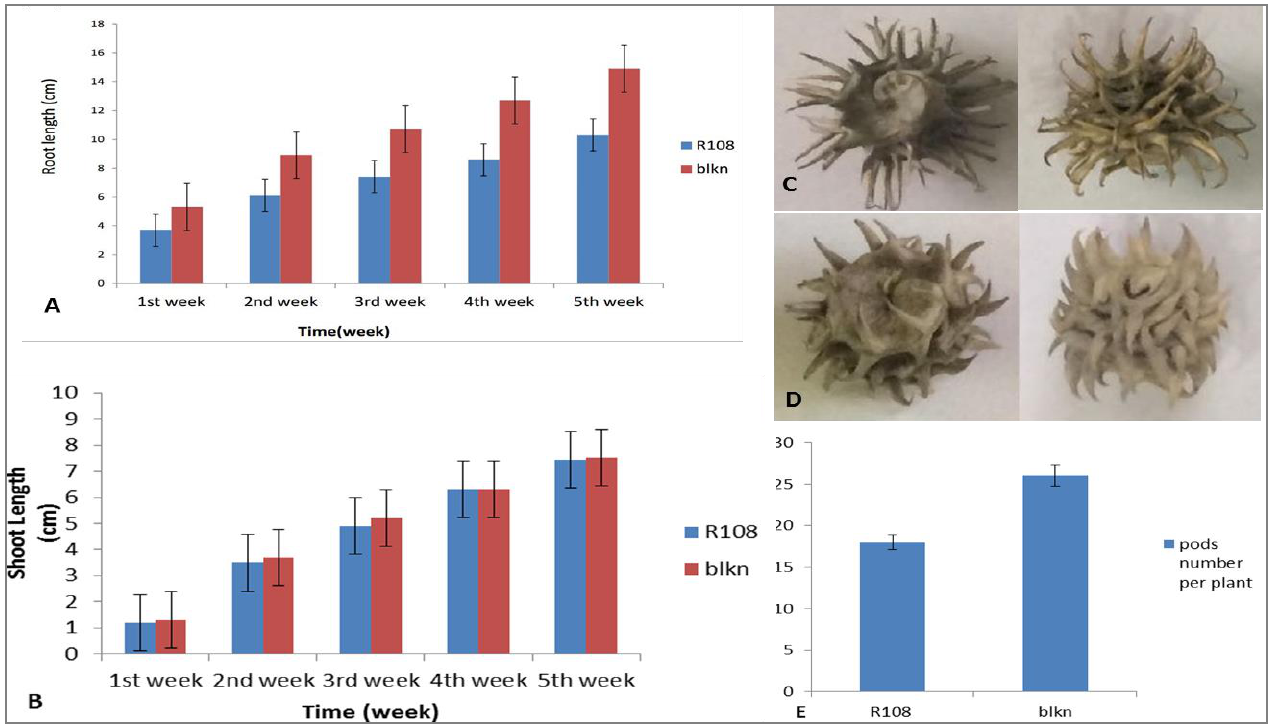
Figure 1. Phenotypic characters of M.truncatula wild type and blkn . (1A) comparison between average root lengths of blkn and R108 is indicating a significance difference between the two types of plants at ( P = 0.01). (1B) the mean value of blkn shoot length was close to mean value of R108 shoot length at ( p >0.05). (1C) mature pods of R108 is showing long spine with anti-clock wise spines direction. (1D) mature compacted pods of blkn with short spines and anti-clock wise direction. (1E) the average number of the produced pods in blkn and R108 with no significant difference at ( p